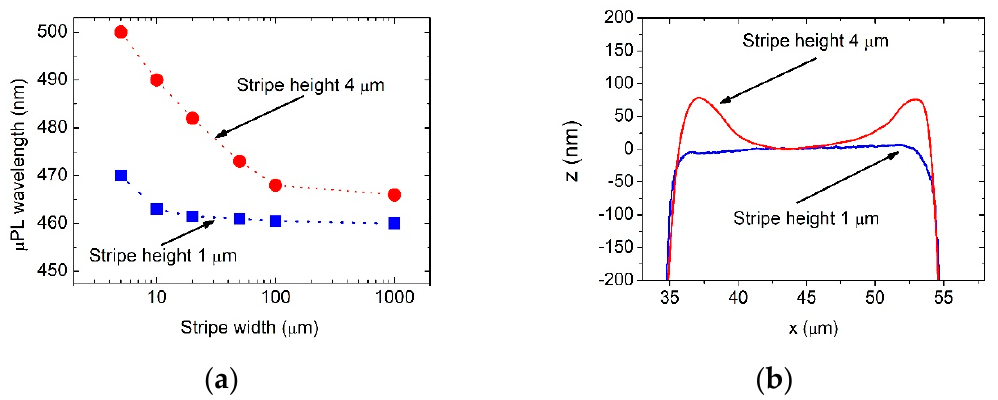
Figure 8. Luminescence ( a ) and surface profiles ( b ) of QW grown on substrates with stripes of different height. di ff erent